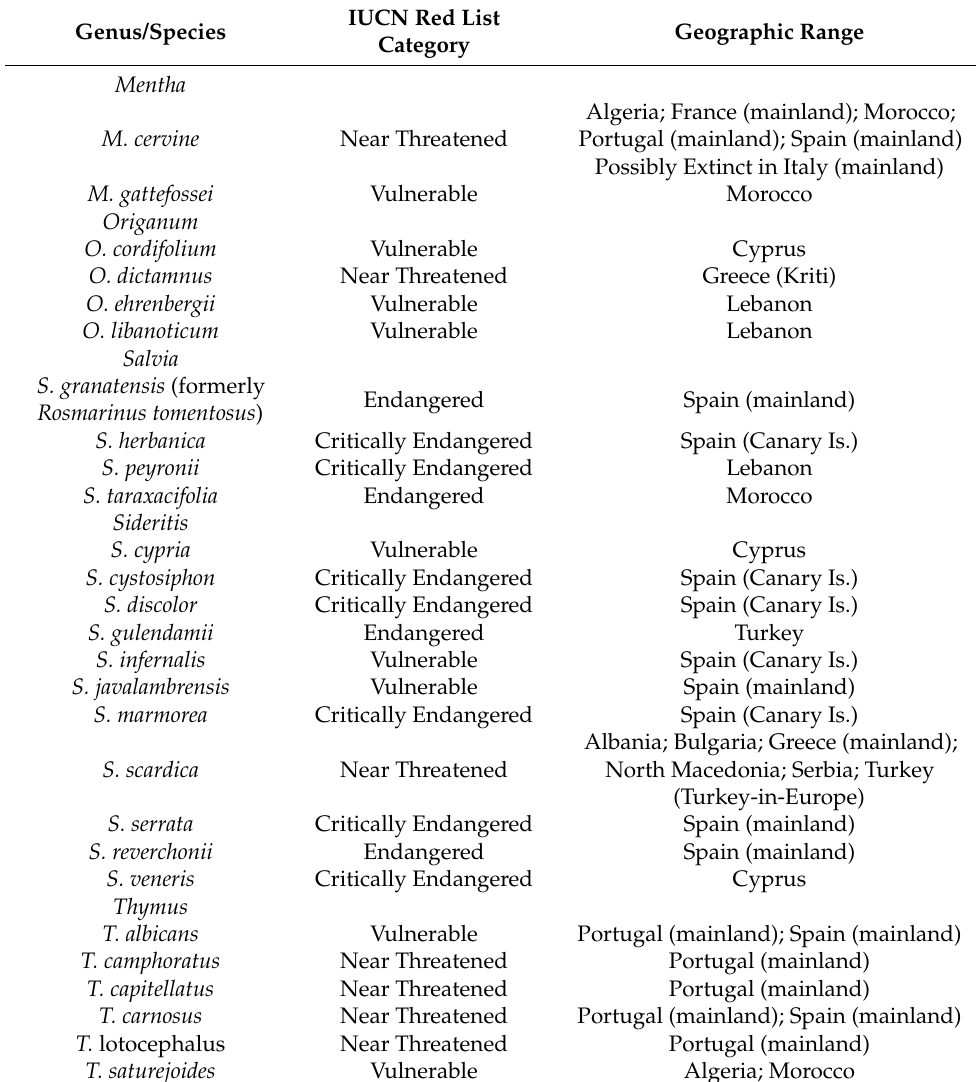
Table 2. Examples of Mediterranean aromatic species listed in the International Union for Conserva- tion of Nature, IUCN Red List of Threatened